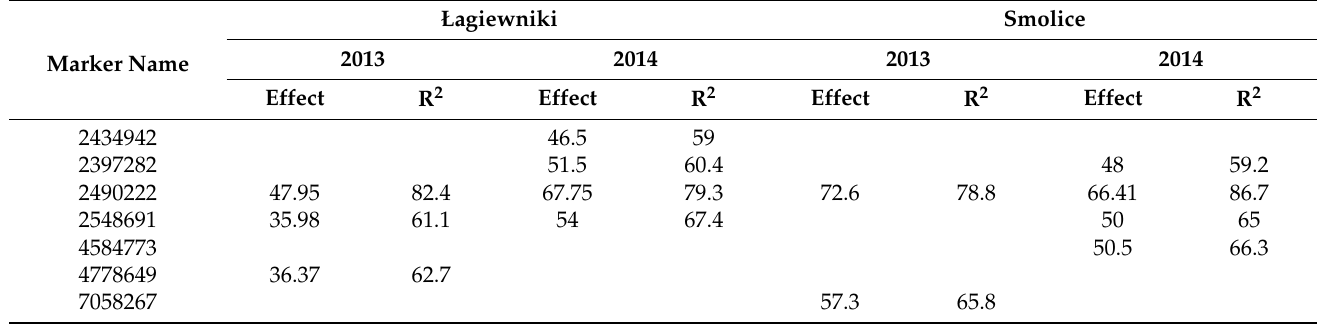
Table 7. Molecular markers (SilicoDArT) significantly (LOD > 3.0) associated with the heterosis effect of mass of grain from the cob (MGC).